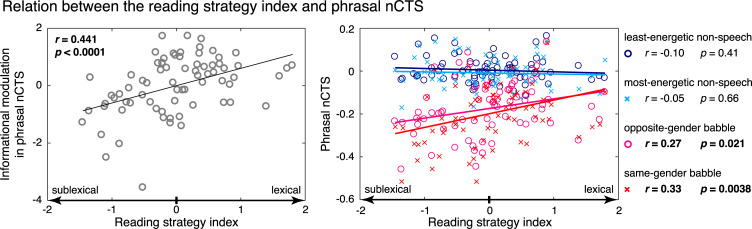
Relation between the reading strategy index and the nCTS at phrasal rate.Left—the informational modulation in phrasal nCTS as a function of the reading strategy index. Gray circles depict participants’ values, and a black trace is the regression line, with correlation and significance values indicated in the top-left corner. Right—the mean nCTS across visual conditions and both hemispheres for the four types of noise: least-energetic nonspeech (blue circles), most-energetic nonspeech (turquoise crosses), opposite-gender babble (red circles), and same-gender babble (pink crosses). Circles and crosses depict participants’ values, and full traces are the regression lines. Correlation and significance level for all noise conditions are indicated on the right of each plot. S3 Data contains the underlying data for this figure. nCTS, normalized cortical tracking of speech.